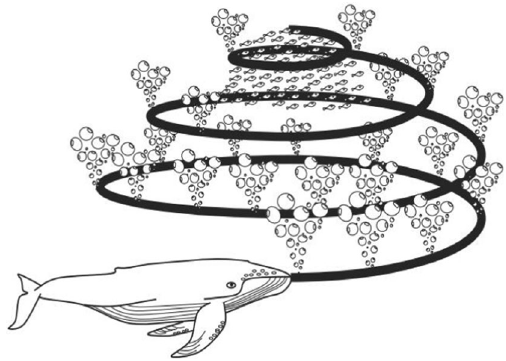
Fig. 1 Bubble-net assaulting